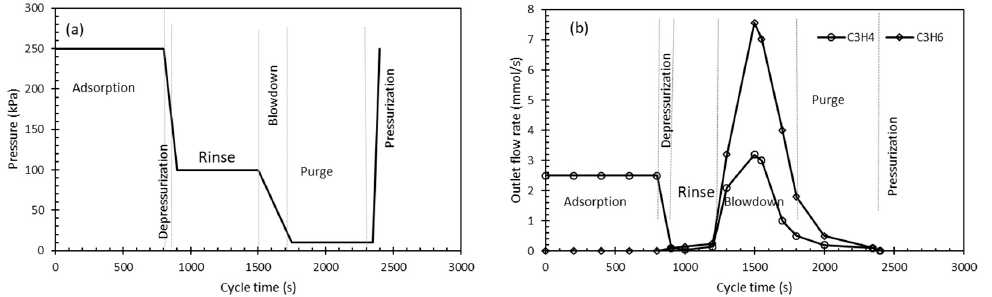
Figure 7. Vacuum swing adsorption (VSA) cycle ( a ) pressure history in the system; ( b ) outlet flow rate of profile for a multi-component system (30:70% v / v propyne/propylene).